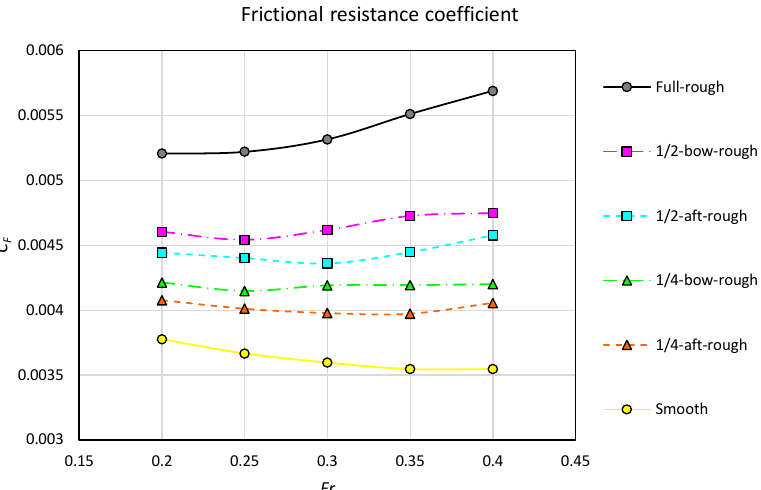
10 of 16 Figure 9. 𝐶 (cid:3021) of the Wigley hull with ½-bow-rough and ½-aft-rough conditions obtained from the current CFD simulations and the EFD result [27]. Figures 10 and 11 compare the frictional and residuary resistance coefficients, 𝐶 (cid:3007) and 𝐶 (cid:3019) , with the different hull conditions, respectively. The frictional and residuary re- sistance were calculated by simply decomposing the total drag into the shear and pressure components. The 𝐶 (cid:3007) and 𝐶 (cid:3019) were calculated as 𝐶 (cid:3007) = 𝑅 (cid:3007) 1 2 𝜌𝑆𝑉 (cid:2870)